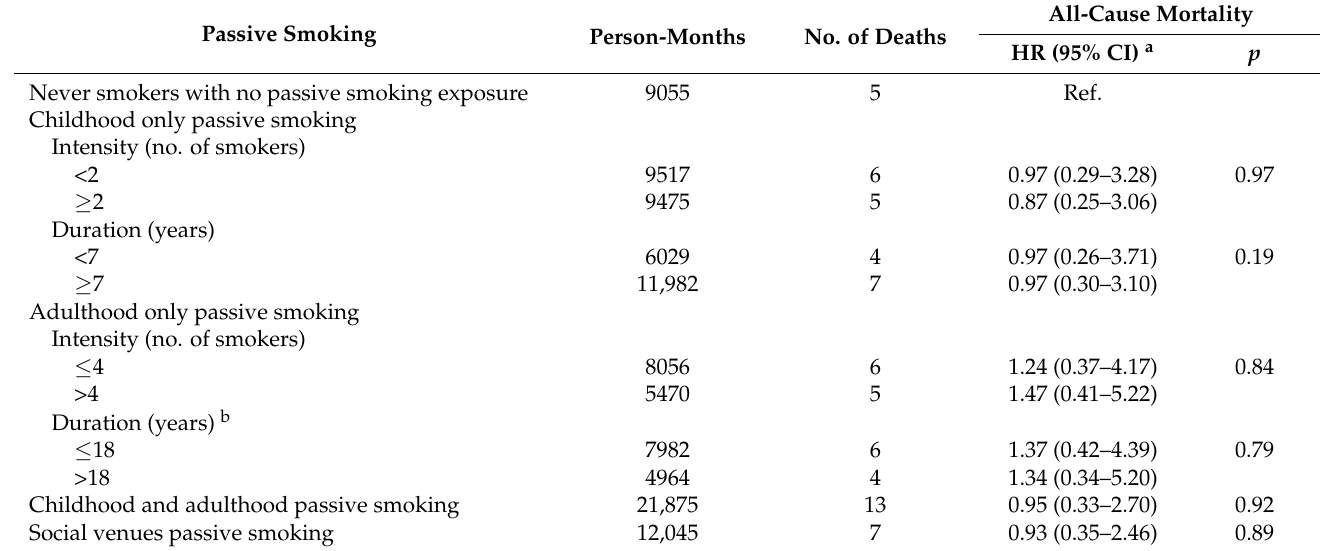
Table 6. Hazard ratios and 95% confidence intervals for all-cause mortality after FL diagnosis in relation to passive smoking exposure among never